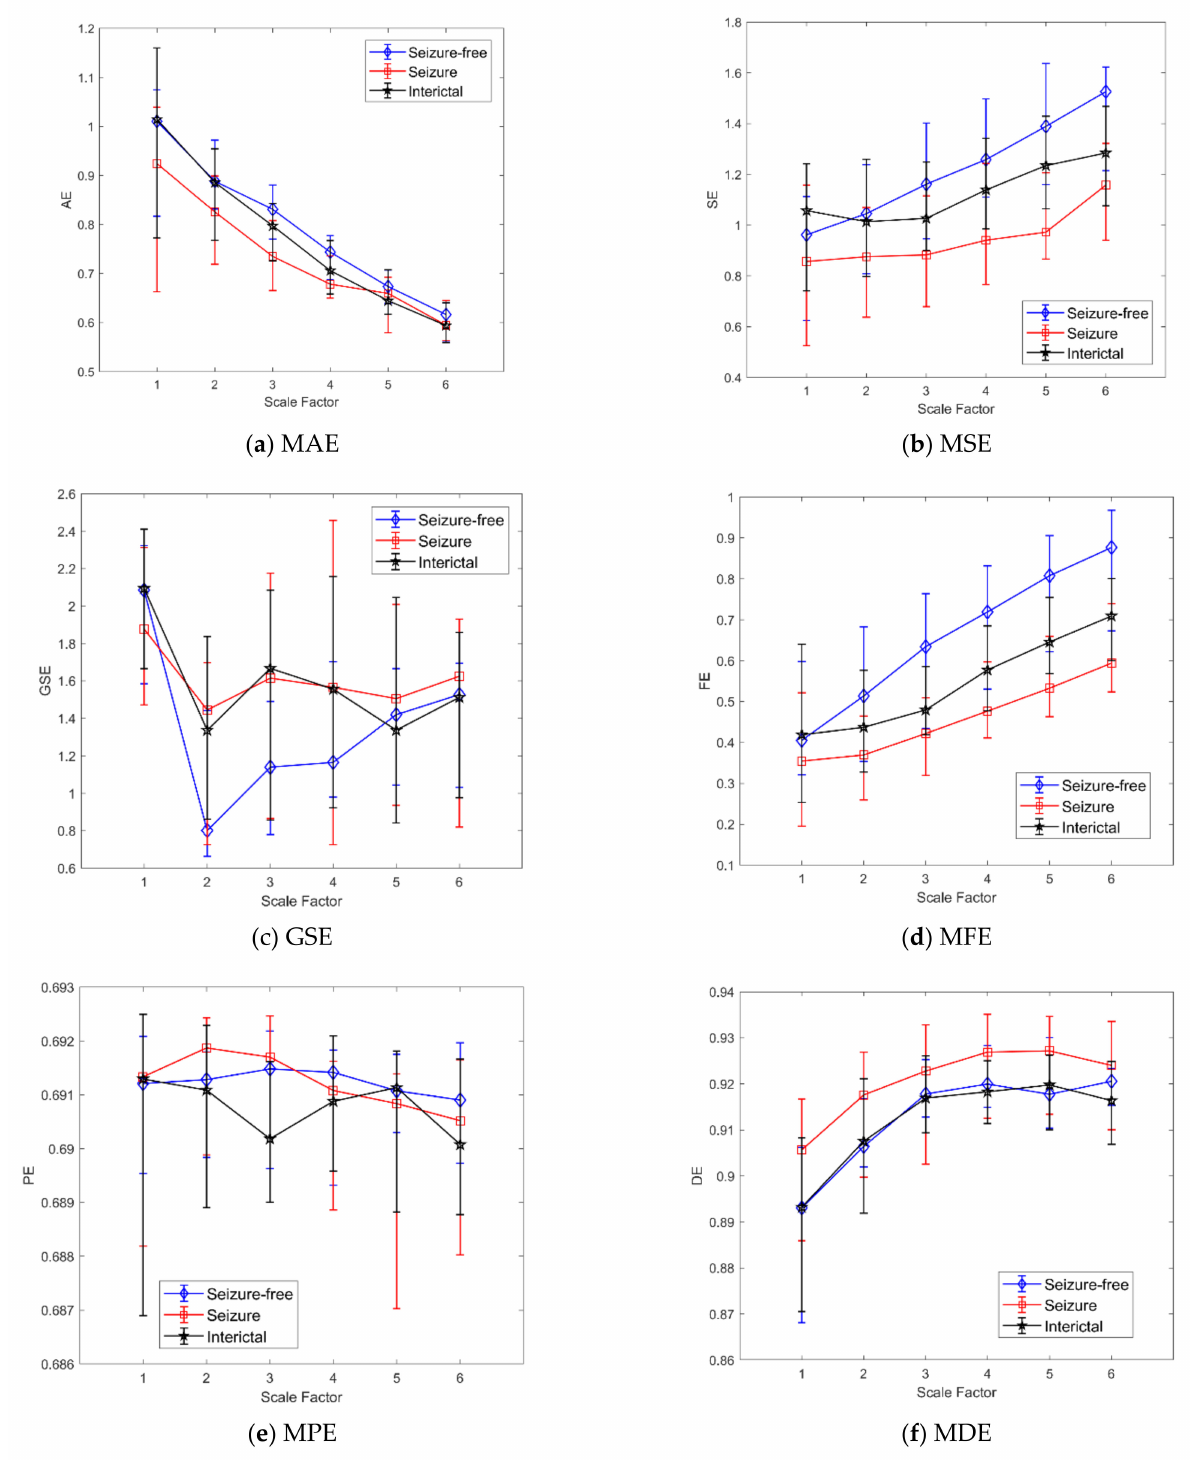
Figure 3. Comparison of the proposed approaches results for scales 1 to 6. ( a ) Approximate Multiscale Entropy. ( b ) Multiscale Sample Entropy. ( c ) Generalized Multiscale Sample Entropy. ( d ) Multiscale Fuzzy Entropy. ( e ) Multiscale Permutation Entropy. ( f ) Multiscale Distribution Entropy. The trends related to the seizure-free windows ( ♦ marker), seizure windows ( (cid:3) marker) and interictal windows ( (cid:73) marker) are shown. The values at each scale represent the median and iqrs among